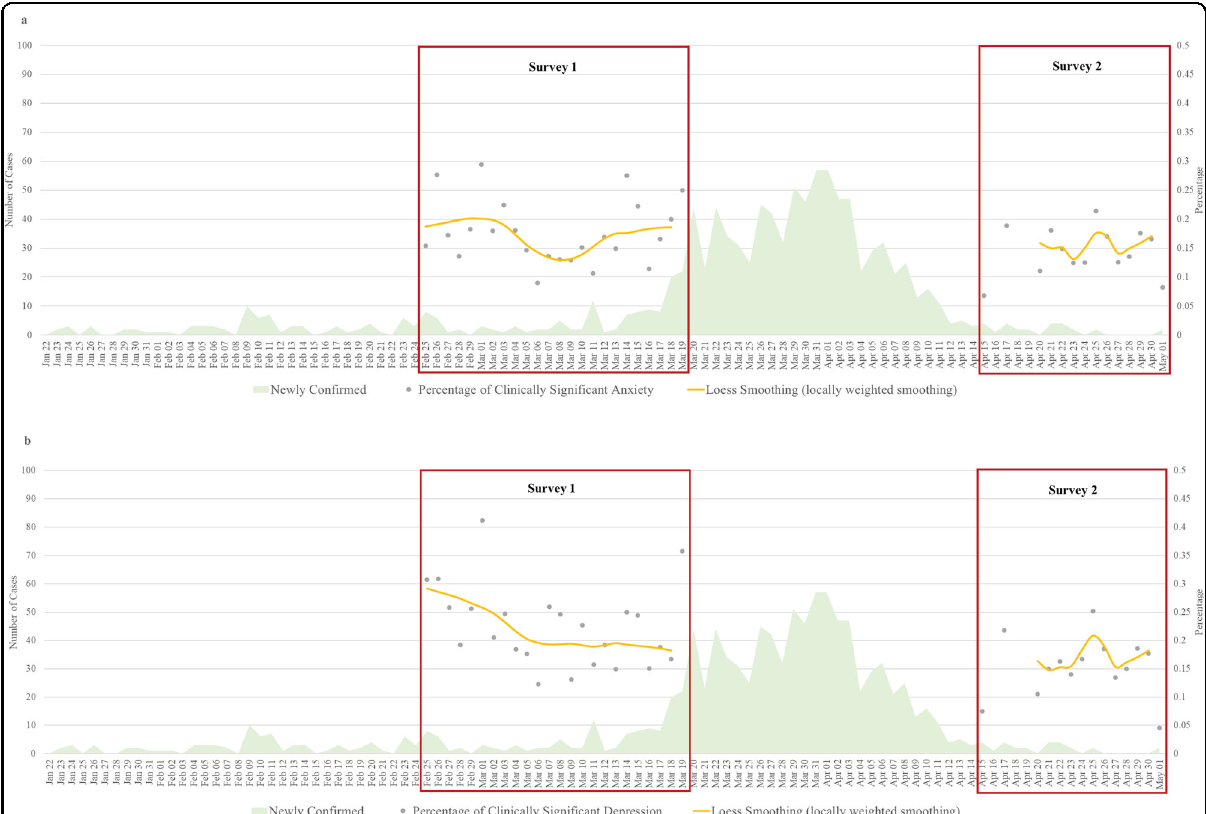
Fig. 2 The trends of clinically signi fi cant anxiety and depression on the day-to-day number of con fi rmed new cases of the COVID-19. a = Anxiety. b = Depression. COVID-19 = Coronavirus disease 2019. Generalized Anxiety Disorder 7-item scale (GAD-7) scores at or exceeding 10 were used to de fi ne clinically signi fi cant anxiety. Patient Health Questionnaire-9 (PHQ-9) scores at or exceeding 10 were used to de fi ne clinically signi fi cant depression. Percentage of clinically signi fi cant anxiety/depression on a particular day represented the number of respondents with clinically signi fi cant anxiety/depression over the total number of respondents on that day. The loess smoothing depicts the trend of daily percentage of clinically signi fi cant anxiety/depression over the survey periods (survey 1: February 25 – March 19, 2020; survey 2: April 15 – May 1, 2020). The red frames indicate the trends of clinically signi fi cant anxiety/depression on the day-to-day number of con fi rmed new cases of the COVID-19. Light green area shows a trend of daily con fi rmed new cases of COVID-19 over the period of January 22 – May 1, 2020. Data on daily con fi rmed new cases was obtained from the Centre for Health Protection website